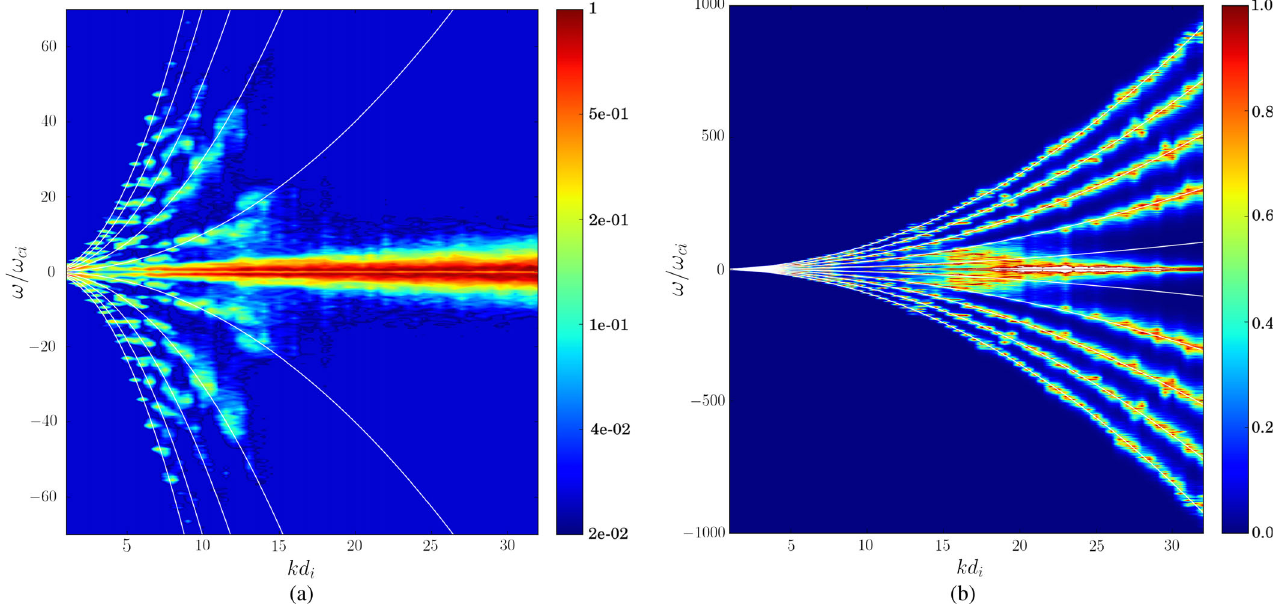
FIG. 12. (a): Mean of five space-time Fourier spectra of the x component of the generalized Elsässer variables Z þ and Z − − (negative frequency) corresponding to five different angles θ ∼ 84 °, 72°, 60°, 45°, 25° (run IV). High frequencies correspond to low angles and reciprocally. Before the mean is taken, each signal is normalized to the maximum value at each fixed k . The color scale is log 10 Z s Λ ð k; ω Þ . Solid white lines are theoretical whistler linear dispersion relations corresponding to the five angles (larger angles correspond to smaller averaged slopes in absolute value). (b) Same as Fig. 12(a) but for the EMHD run V ( u ¼ 0 ). Note that contrary to Fig. 12(a), the color scale is linear; frequency scales are also